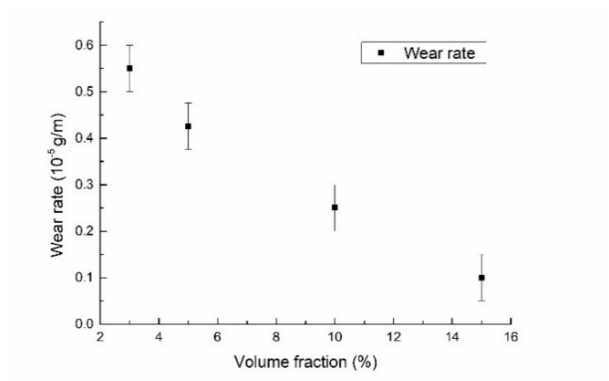
Figure 15. E ff ect of N-SiCp volume fraction on the wear rate of the composite under 4.5 GPa and 550 ◦